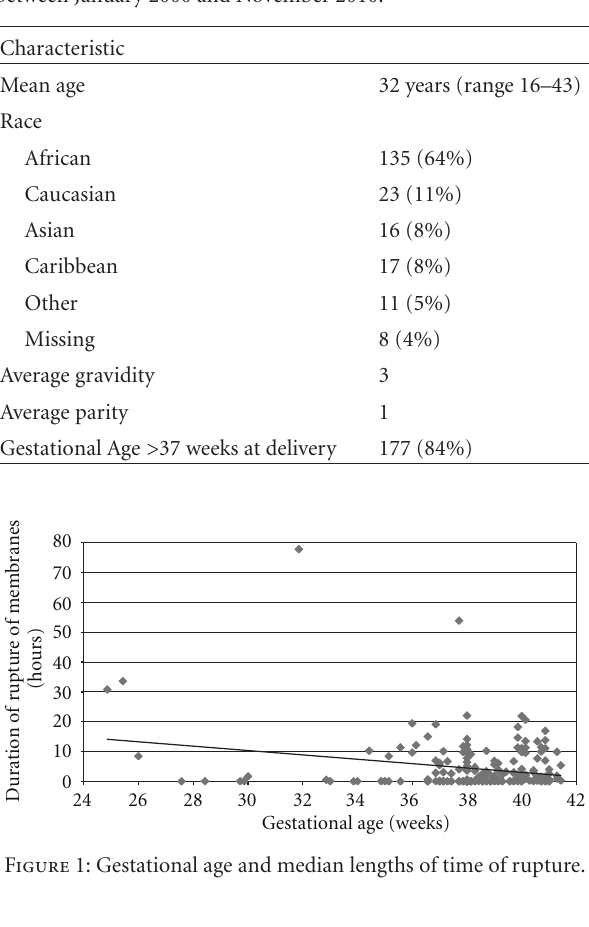
Table 1: Optimally managed HIV-positive women who delivered between January 2000 and November 2010.